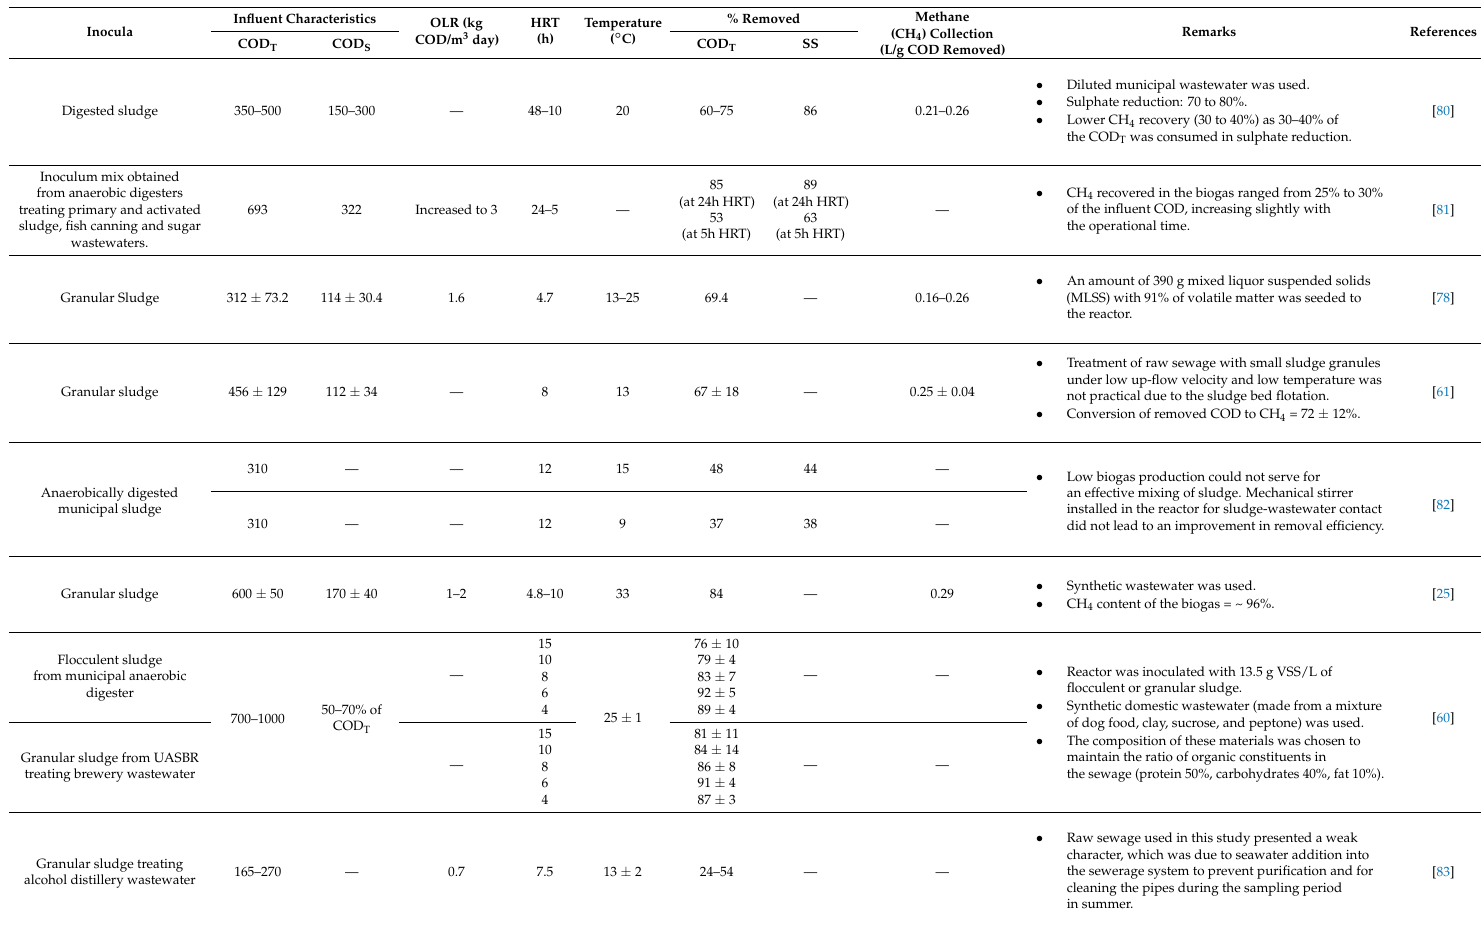
Table 1. Selected key operating parameters and performance of laboratory-scale (reactor size range 2–35 L) UASB systems studied by different researchers.